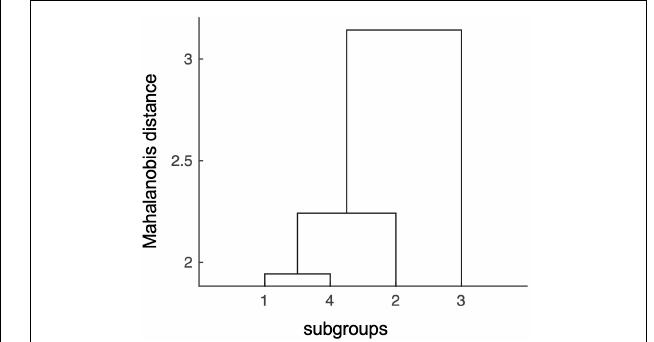
FIGURE 3 | Mahalanobis distances of hippocampal subfield volumes indicate distinct effects conferred by the high-risk subgroup #3. In the Mahalanobis dendrogram statistic independence of data points is indicated by the length of the arms in the hierarchical binary cluster tree. The matrix shows that there is a low degree of statistical relatedness between effects of the high-risk subgroup #3 (high-A β -low-episodic memory group), with effects conferred by the other three subgroups: low-A β -low-episodic memory (subgroup 1), low-A β -high-episodic memory (subgroup 2), and high-A β -high-episodic memory (subgroup